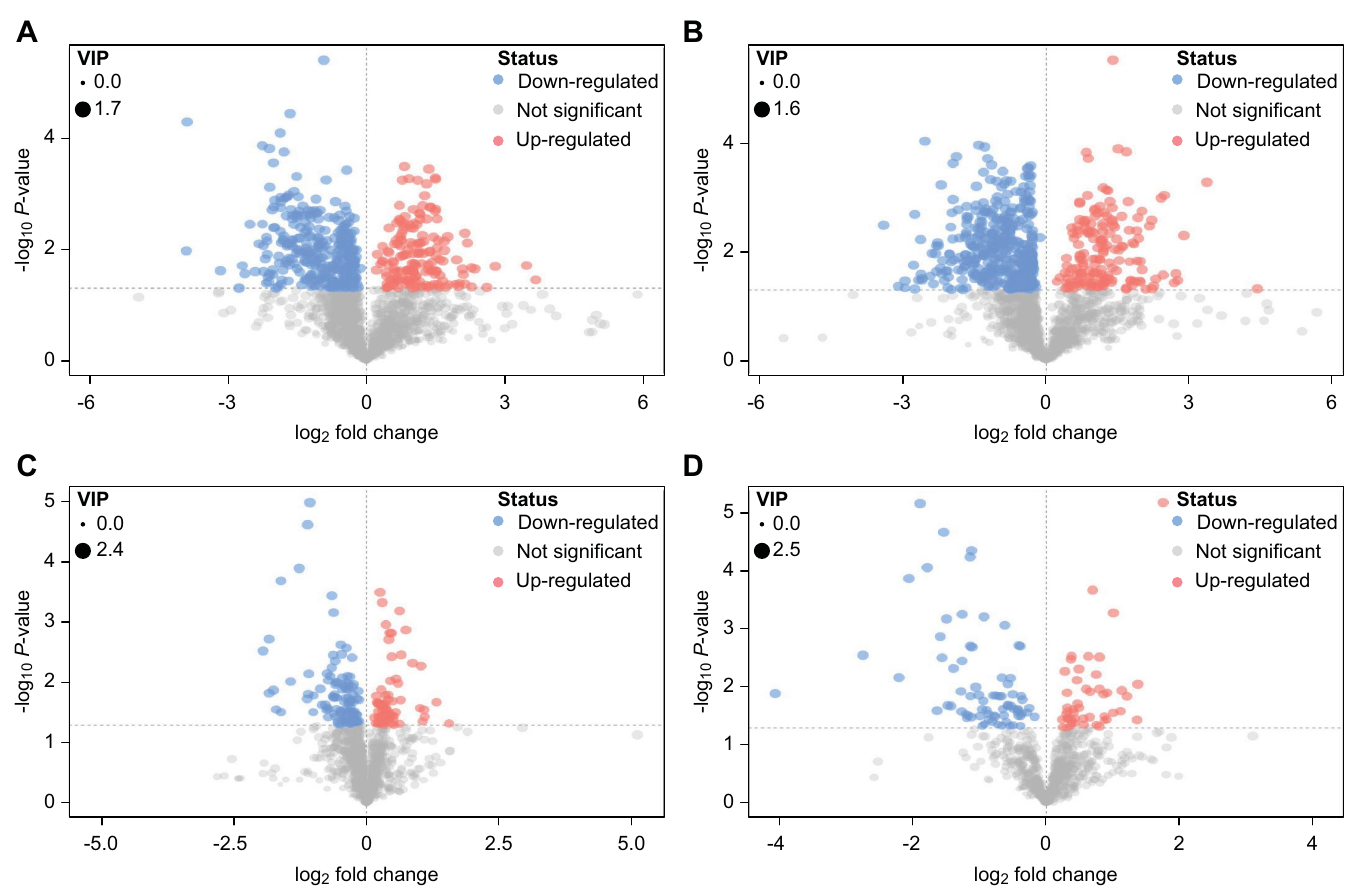
Fig 2. Volcano plots for the LCD vs . HCD groups. A and B were respectively derived from POS and NEG of the rumen fluid, and C and D were respectively derived from POS and NEG of the plasma samples. In the volcano plot, each point represents a metabolite, and the point size represents the VIP value of this metabolite in the OPLS-DA model. Compared with the LCD group, red indicates a significantly upregulated metabolite in the HCD group, whereas blue indicates the opposite, and gray shows no significant difference between the two groups.